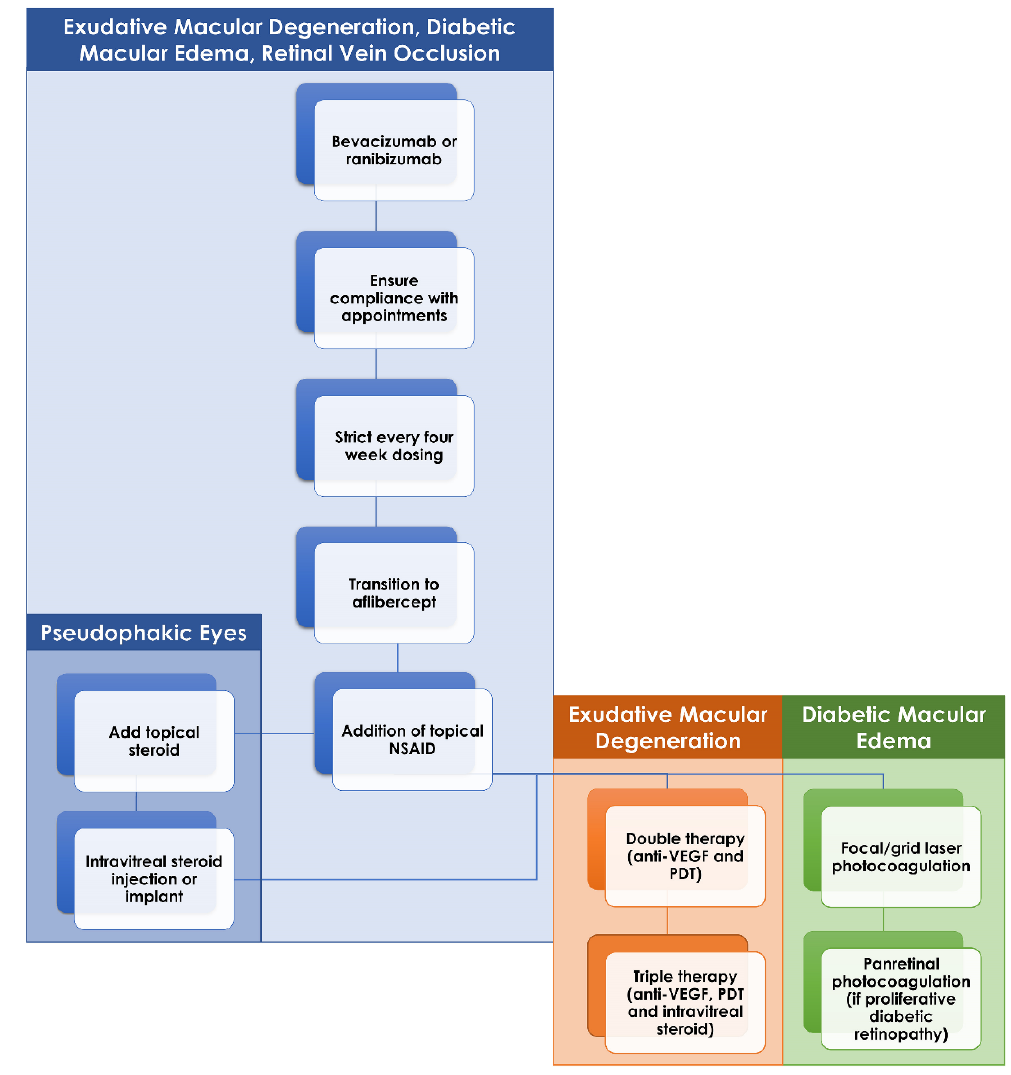
Figure 3. Flow chart of recommend management of anti-VEGF-resistant macular edema in exudative macular degeneration (eAMD), diabetic retinopathy and retinal vein occlusions. If initial therapy with bevacizumab or ranibizumab fails, then ensuring patient adherence to injection schedule is a key first step. Following this would be a strict injection schedule, one injection every four weeks, and transition to aflibercept if still active. Topical therapy with nonsteroidal anti-inflammatory drugs and, if pseudophakic, steroids can be initiated if the macular edema remains resistant. Intravitreal steroid injections or implants can be added in those eyes without contraindications. Finally, in eAMD and diabetic retinopathy, the addition of laser therapy (photodynamic therapy for eAMD and focal/grid laser or panretinal photocoagulation in diabetic retinopathy) can be considered in those eyes that remain resistant to all of the aforementioned treatments.